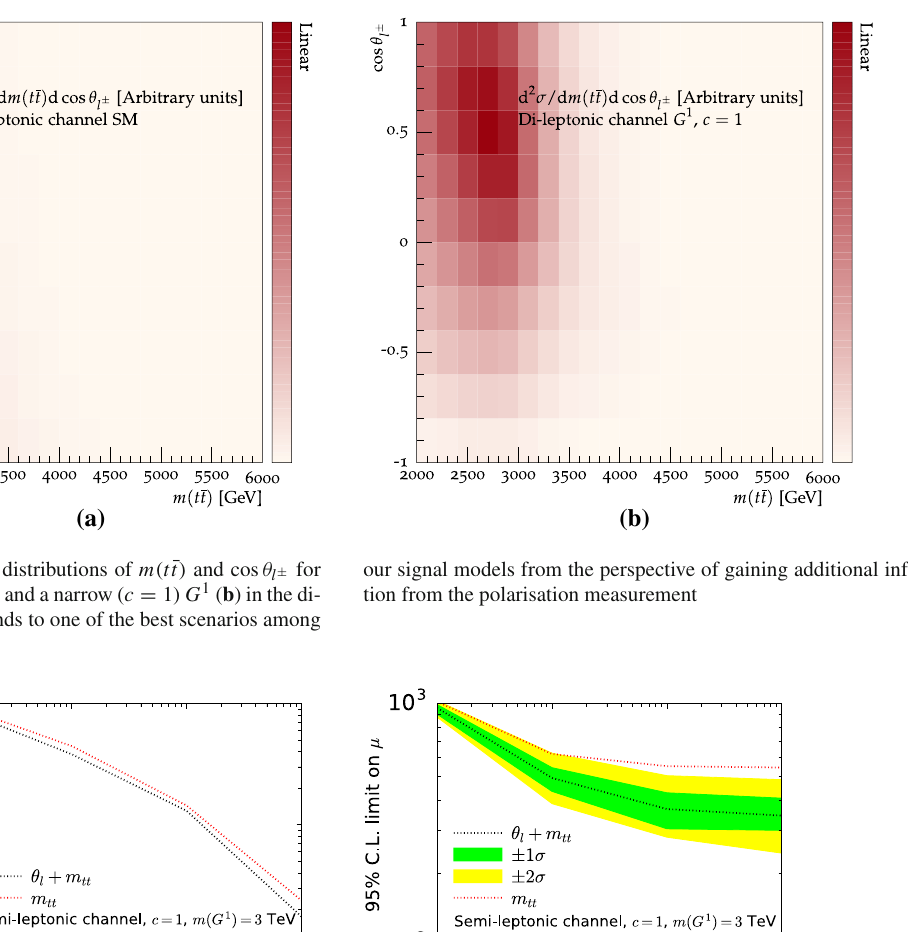
luminosities using m ( t ¯ t ) and cos θ l ± ( black line ) and only using m ( t ¯ t ) ( red line ) with the semi-leptonic analysis. The ± σ bands are for the combined result. μ = 1 corresponds to σ × Br ( G 1 → t ¯ t ) = 0 . 3